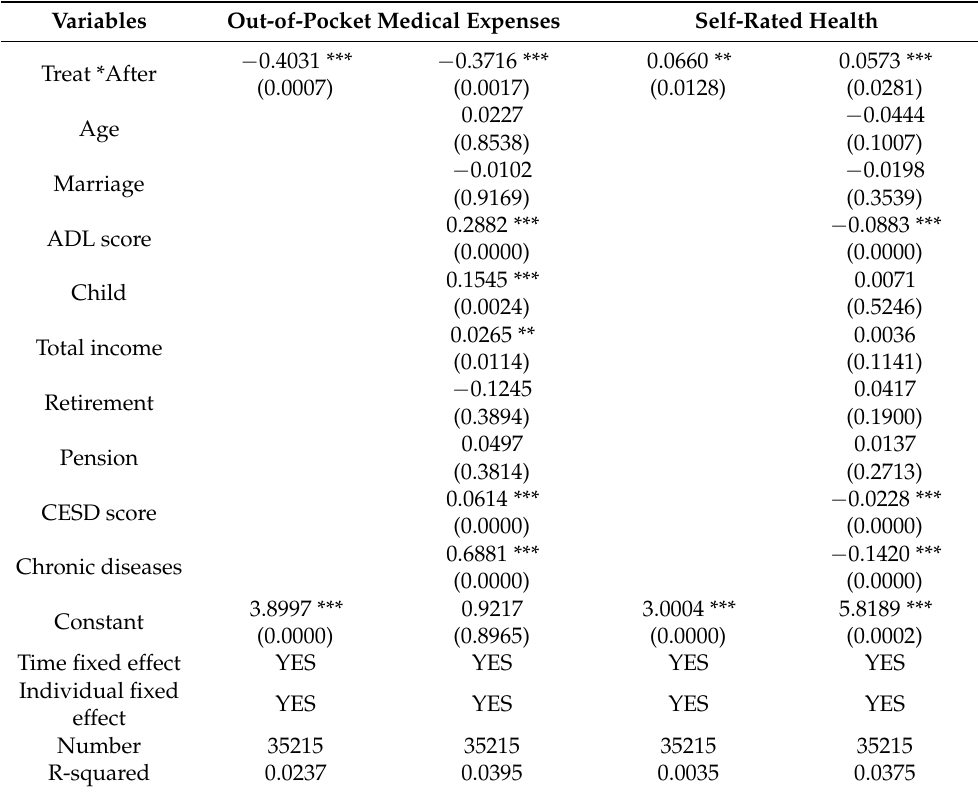
Table 5. DID results with matched